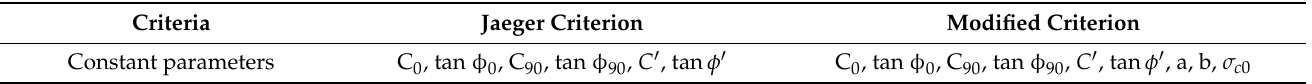
Table 21. Material constants included in the initial and modified